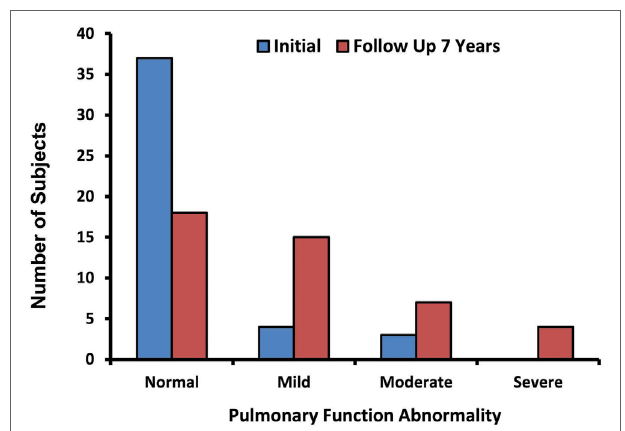
FigUre 2 | Pulmonary function abnormalities among the oil spill cleanup workers during their initial and later follow-up